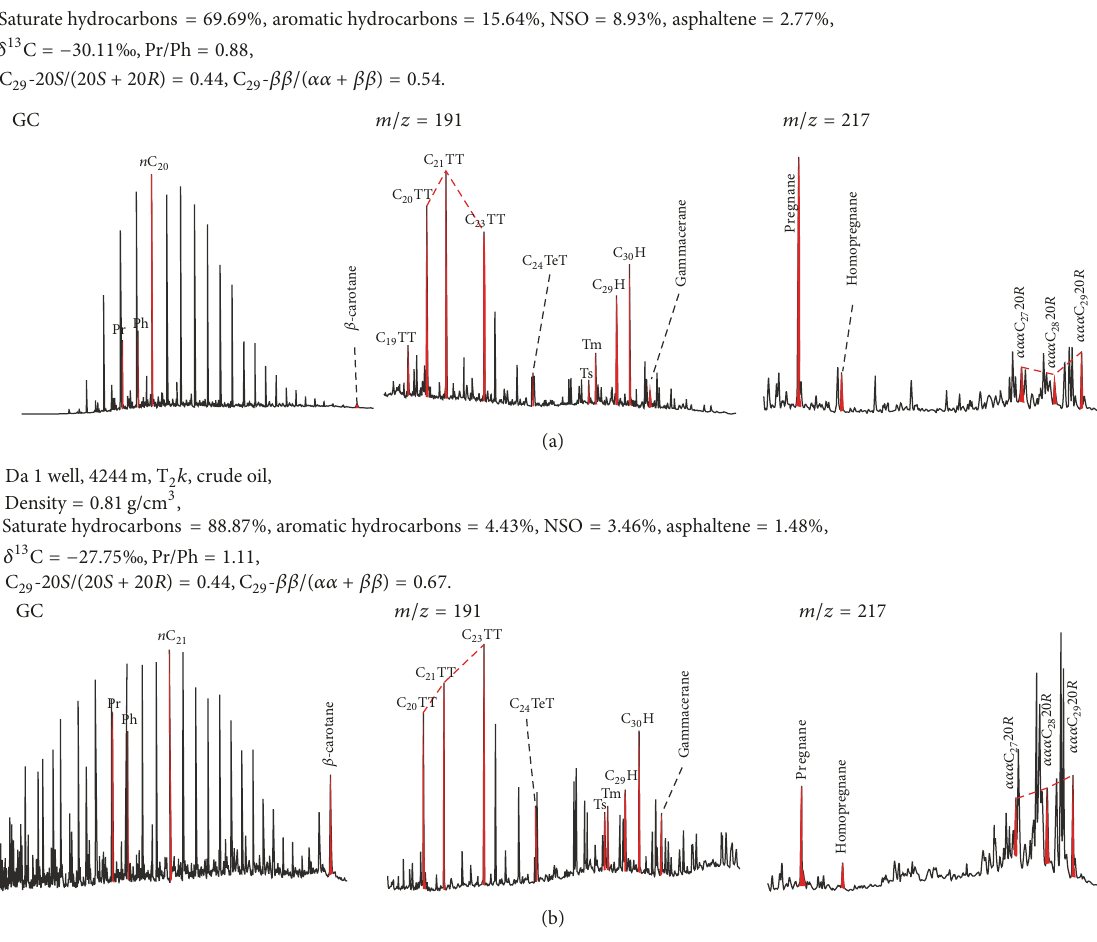
Figure 6: Gas and mass chromatograms of Triassic-reservoired oils and reservoir extracts in the central Junggar Basin. (a) The end-member type A. (b) The end-member type B. See text for the classification of these two